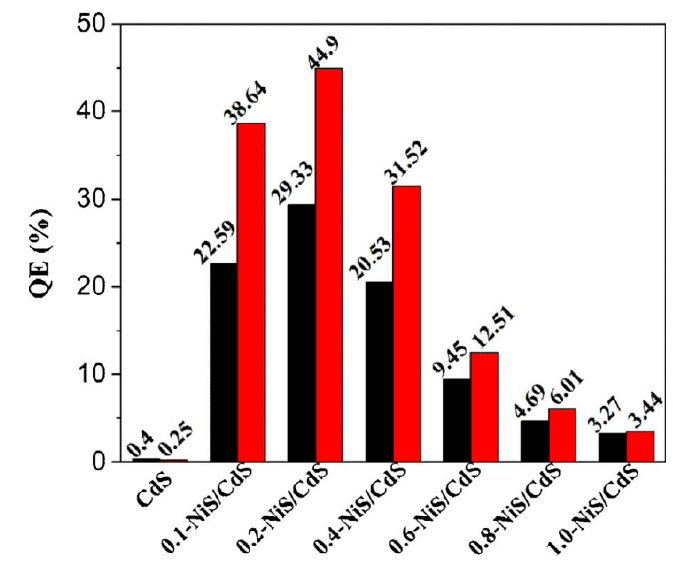
Figure 8. AQE for photocatalytic reforming of biomass on NiS ‐ CdS composites (black column: lactic acid; red column: lignin acid) (Adapted from Ref. [91]).